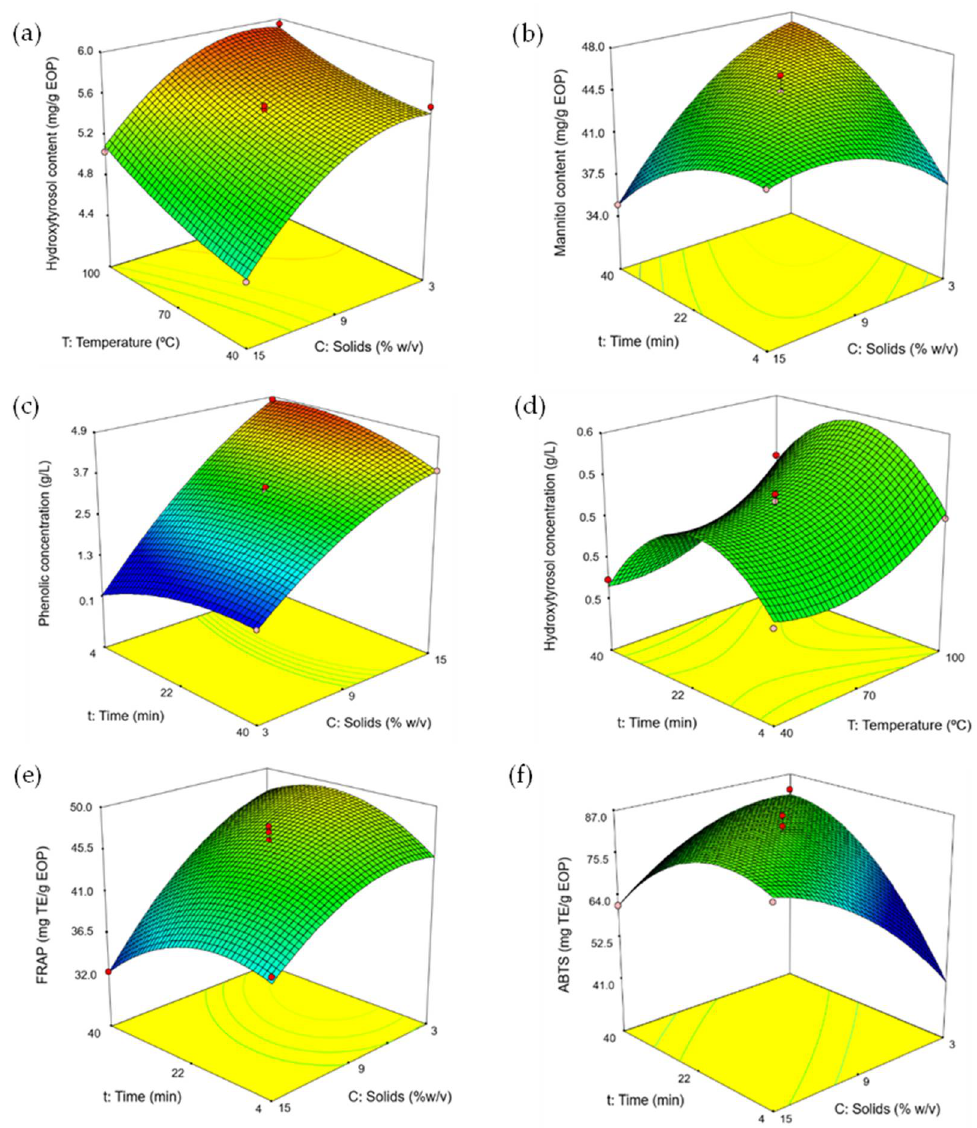
Figure 2. Response surfaces for the Box–Behnken design of: ( a ) hydroxytyrosol content, ( b ) mannitol content, ( c ) phenolic concentration, ( d ) hydroxytyrosol concentration, ( e ) FRAP assay, and ( f ) ABTS assay. In each figure, the third factor was fixed at the intermediate level: 9% solid loading ( d ), 22 min ( a ), or 70 °C ( b , c , e , f ).